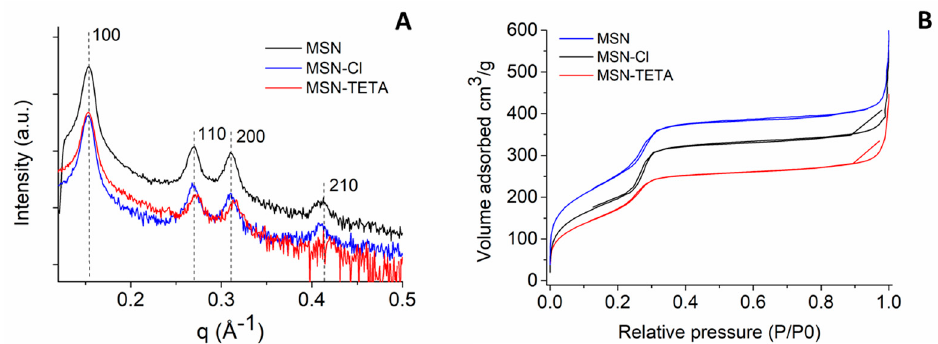
Figure 2 . ( A ) SAXS patterns and ( B ) Adsorption/desorption N 2 of MSN, MSN − Cl, MSN − TETA samples. Table 1. Surface area (S BET ), pore volume (V p ), lattice spacing ( a ), zeta potential ( ζ ) and functionalization loadings (L) of MSN, MSN-Cl and MSN-TETA samples. Sample